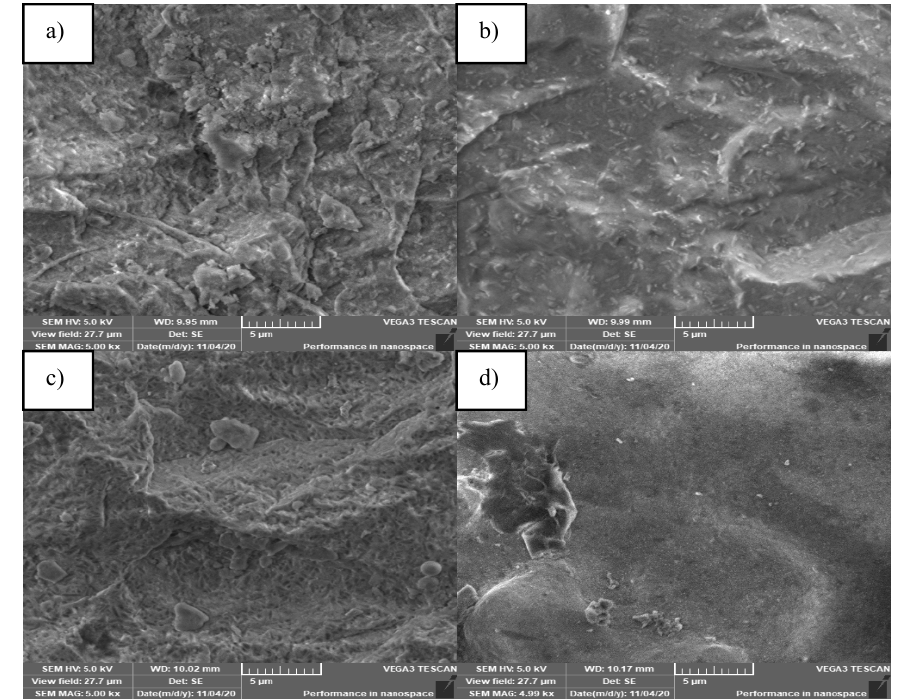
Figure 2. SEM images of the aged samples ( a ) LS10, ( b ) LS11, ( c ) LS20, and ( d ) LS21. Magnification is ×5000.